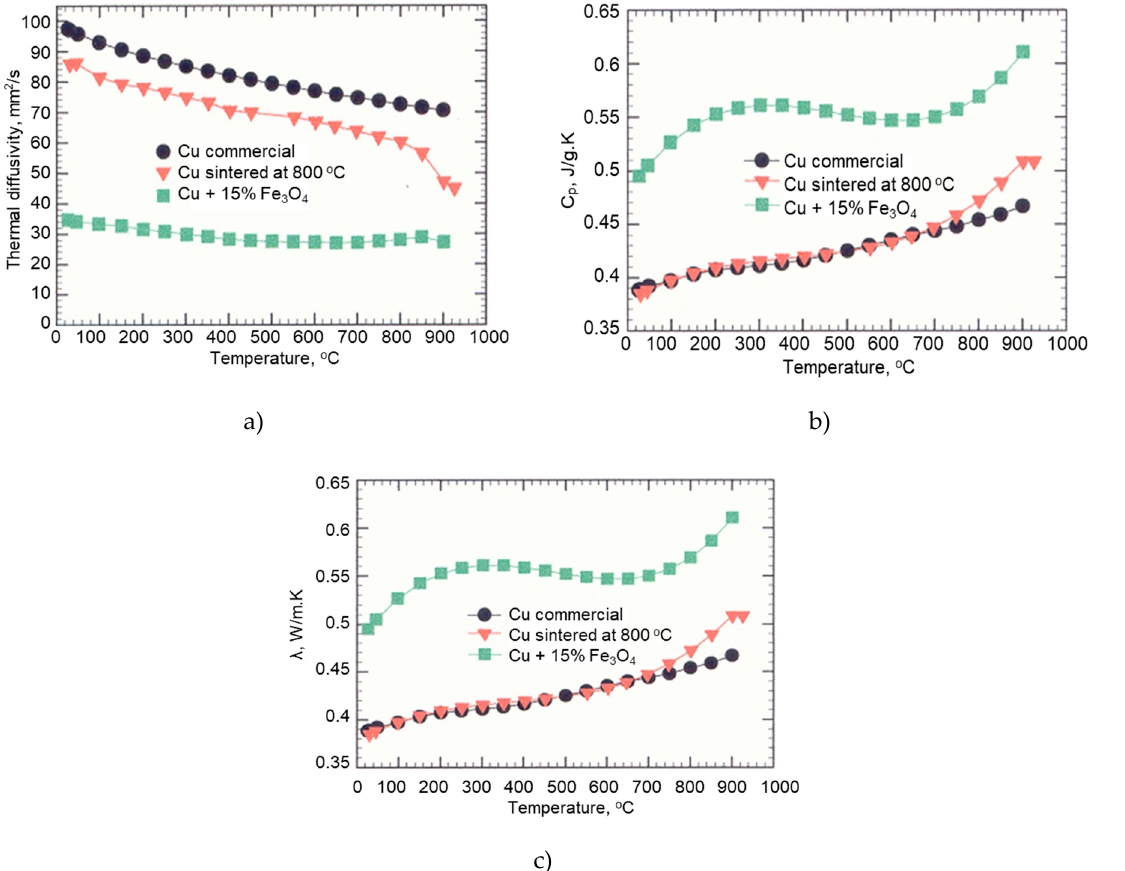
Figure 16. Thermal properties of commercial Cu, nanocomposites of Cu and Cu-15%Fe 3 O 4 sintered at 800 ◦ C: ( a ) thermal di ff usivity; ( b ) specific heat; and ( c ) thermal